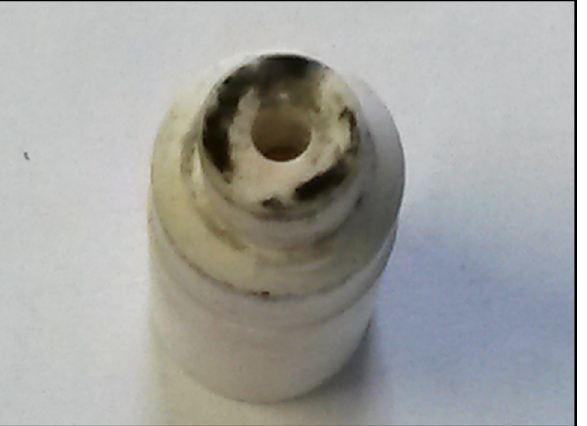
Figure 2. The influence of pressure on hydrocarbon concentration for plasma-catalytic FTS (NTP + 2 or 6 wt% Co catalyst) at discharge times of 10 and 60 s; ( a ) methane, ( b ) ethane, ( c ) ethylene, ( d ) propane and ( e ) propylene. Legend: ■— 6 wt% Co (60 s); ▲ —6 wt% Co (10 s); □ —2 wt% Co (60 s); Δ —2 wt% Co (10 s); ♦ —6 wt % Co (arc extinguished < 60 s). Operating conditions: Syngas (H 2 /CO) ratio: 2.2:1; current: 350 mA; inter-electrode gap: 1 mm; wall temperature: 25 °C. Error bars (vertical): Expanded experimental hydrocarbon concentration uncertainty of